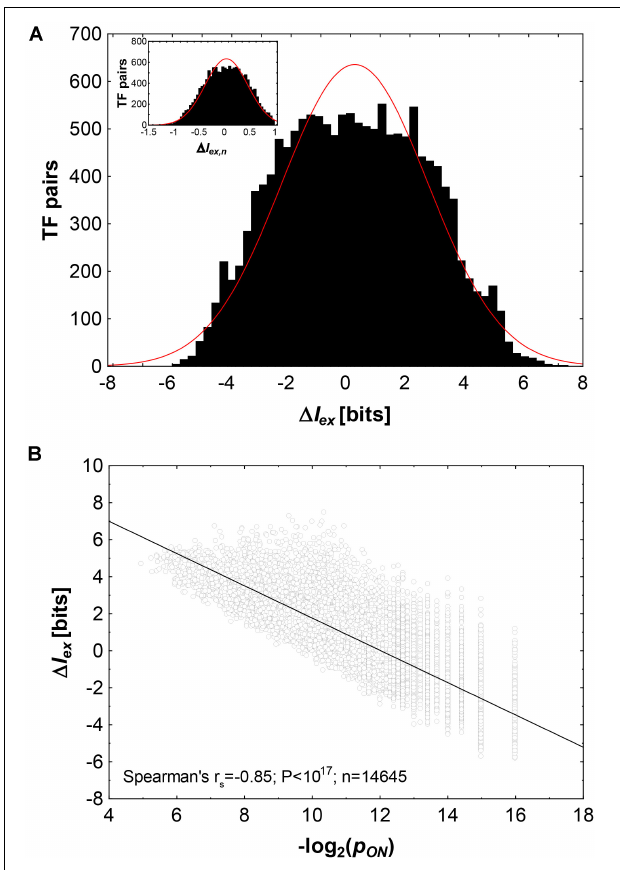
FIGURE 2 | The informational cost of exaptation in transcription factor binding phenotypes. (A) Histogram of (cid:49) I ex (in bits) and (cid:49) I ex , n (inset) for 14,645 pairs of transcription factors where p ON > 0. The red line shows a Gaussian distribution. (B) (cid:49) I ex (in bits) as a function of the negative binary logarithm of p ON , the fraction of genotypes (transcription factor binding sites) that can bind both factors in a pair. The black line is a linear regression line.